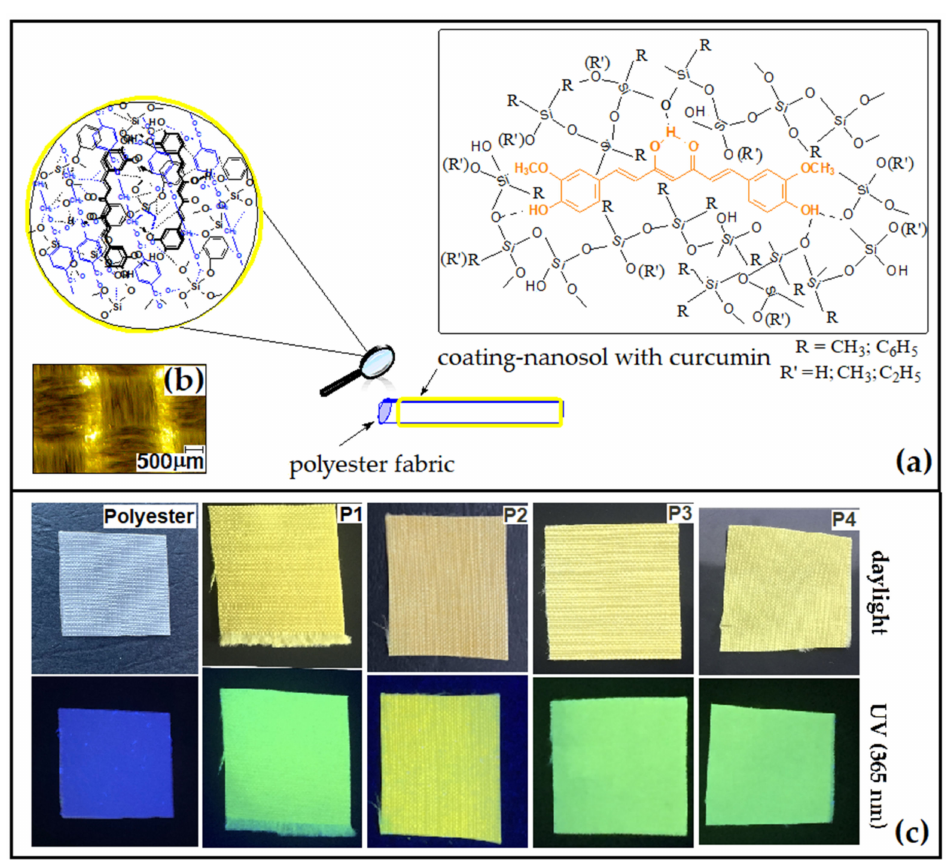
Figure 2. Nanocomposite coated polyester materials ( a ), optical image ( b ) and fluorescence emission during excitation at 365 nm ( c